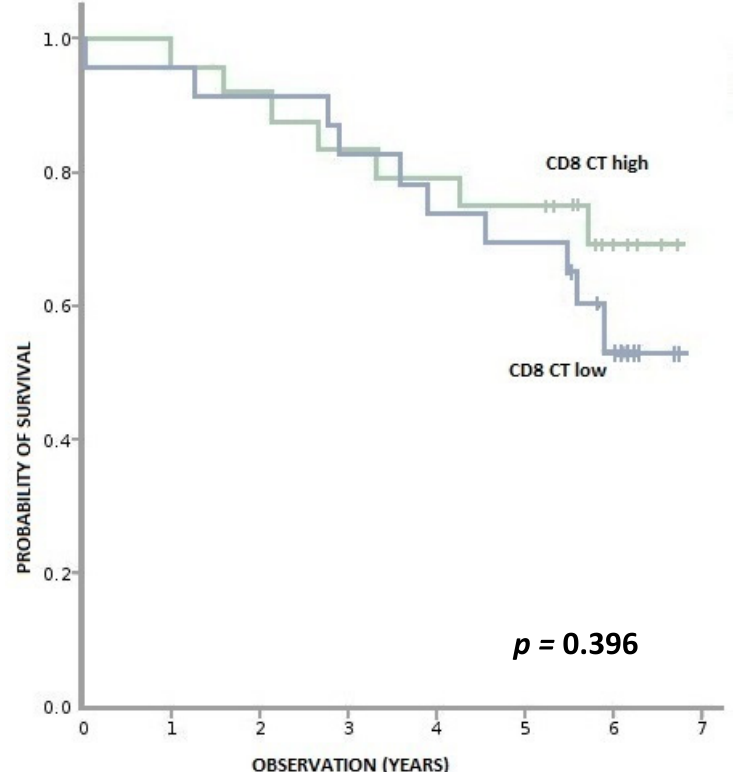
Figure A4. Overall survival according to density of CD8+ lymphocytes in CT (tumor center). CD8+ CT high— ≥ 404 per 0.56 mm 2, CD8+ CT low—< 404 per 0.56 mm 2.